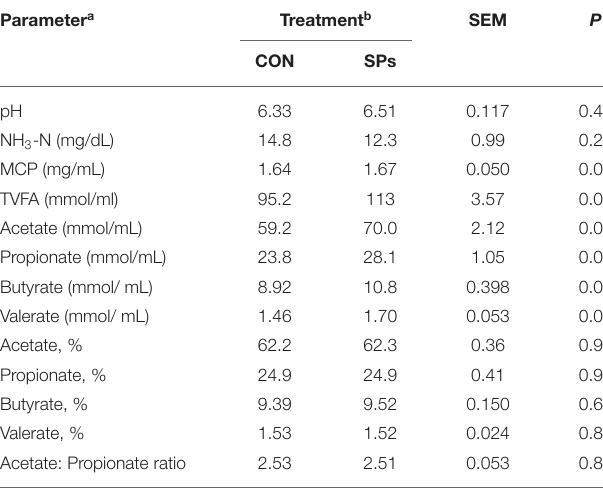
TABLE 6 | Effects of the dietary supplementation of soybean peptides (SPs) on the rumen fluid fermentation profile of lactating dairy cows on the last day of the experiment. Parameter a Treatment b